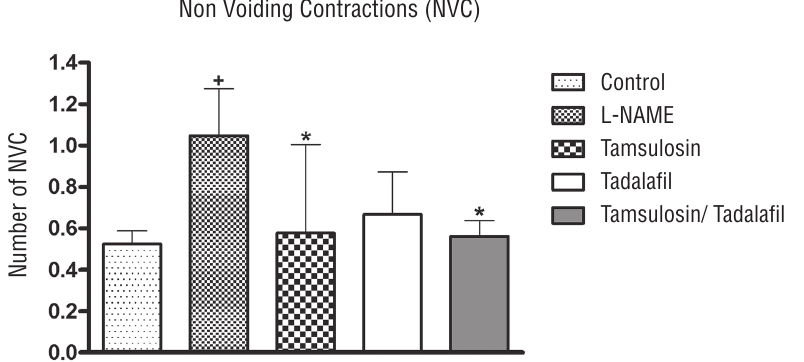
test)+P<0.05 comparing L-NAME with control; *P<0.05 comparing Tamsulosin and Tamsulosin/Tadalafil groups with L-NAME. (P refers to Tukey´s multiple comparision